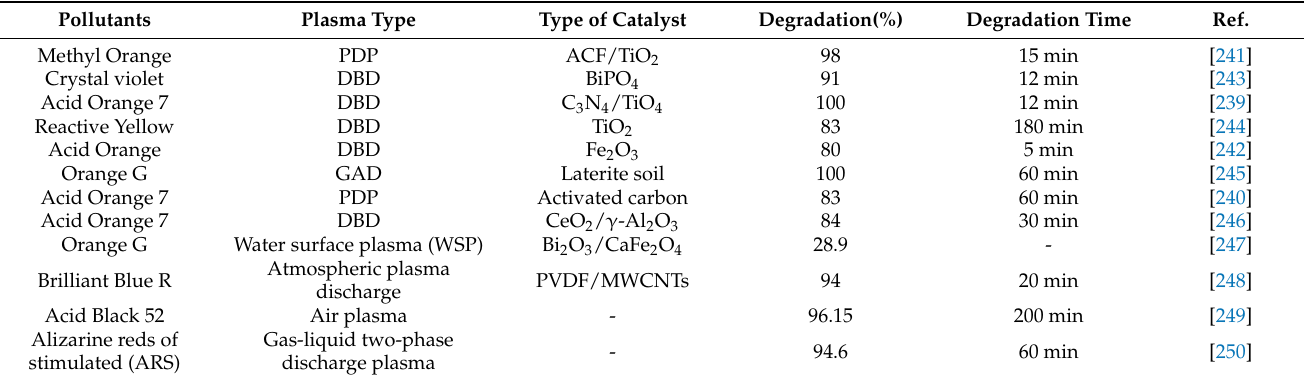
Table 7. A summary of the key operating conditions and catalyst utilized for the degradation of dyes in aqueous phase by NTP combined with a catalyst.